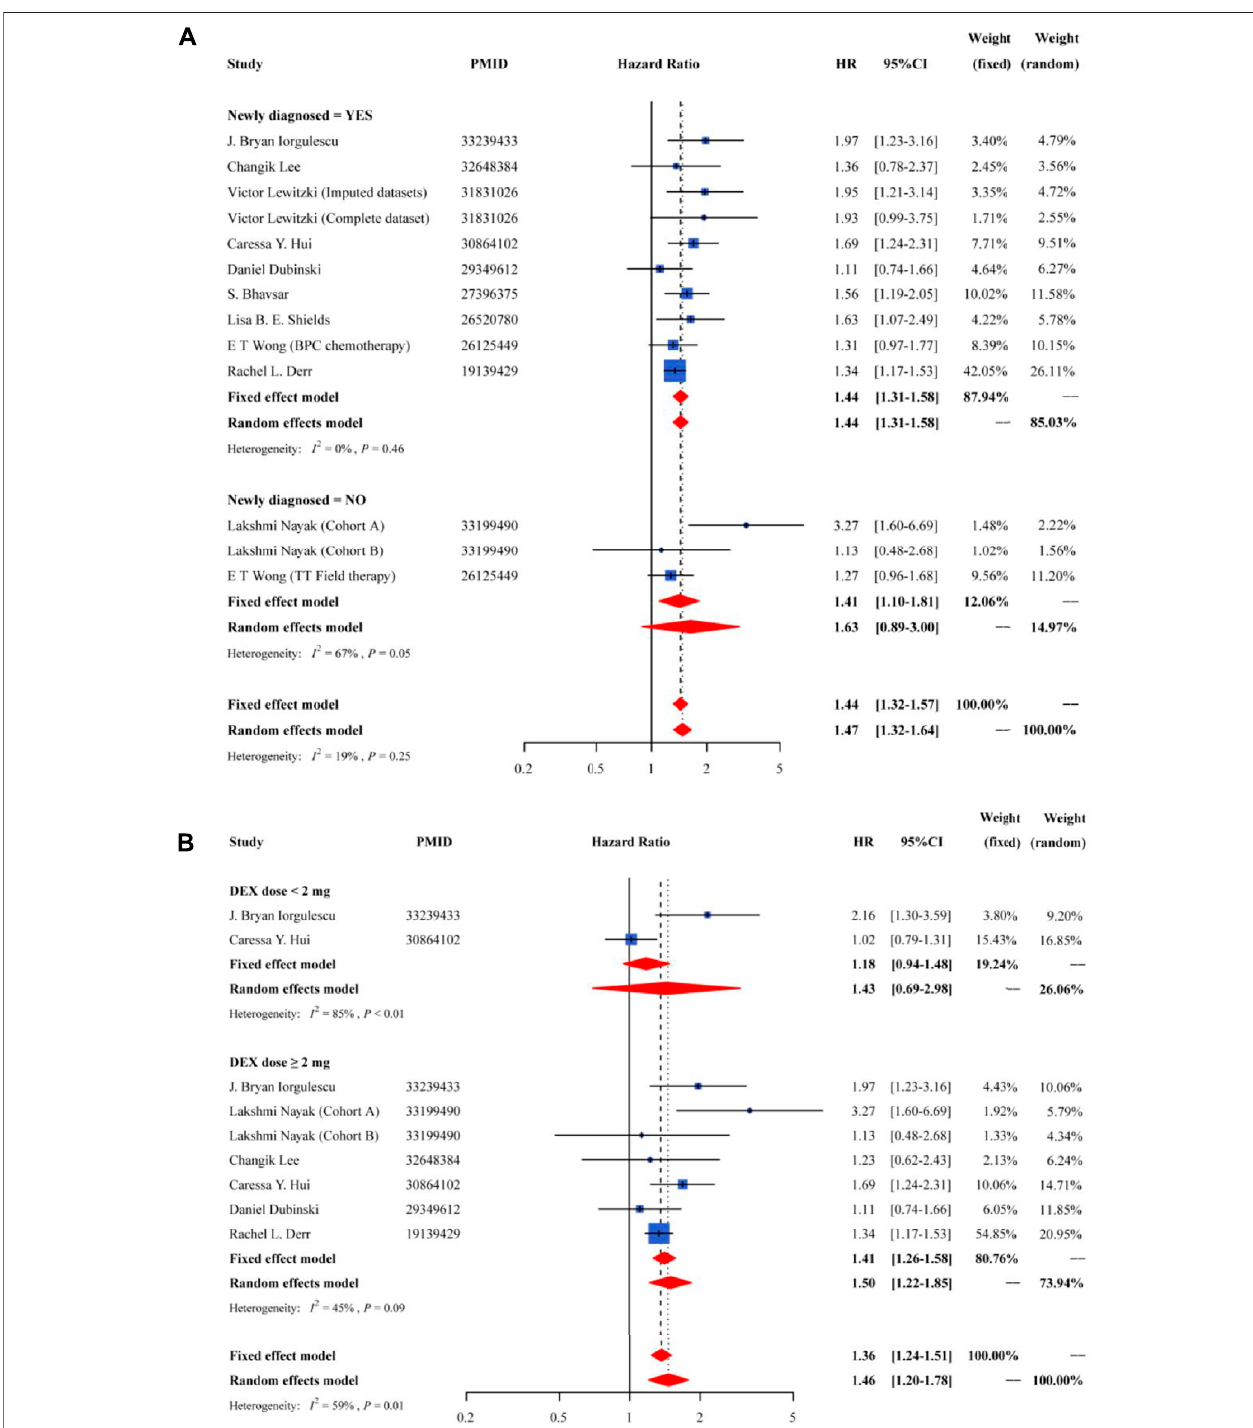
FIGURE 3 | Forest plot of the pooled HR and 95% CI for OS in subgroup of newly diagnosed or not (A) and subgroup of different DEX dose (B) .